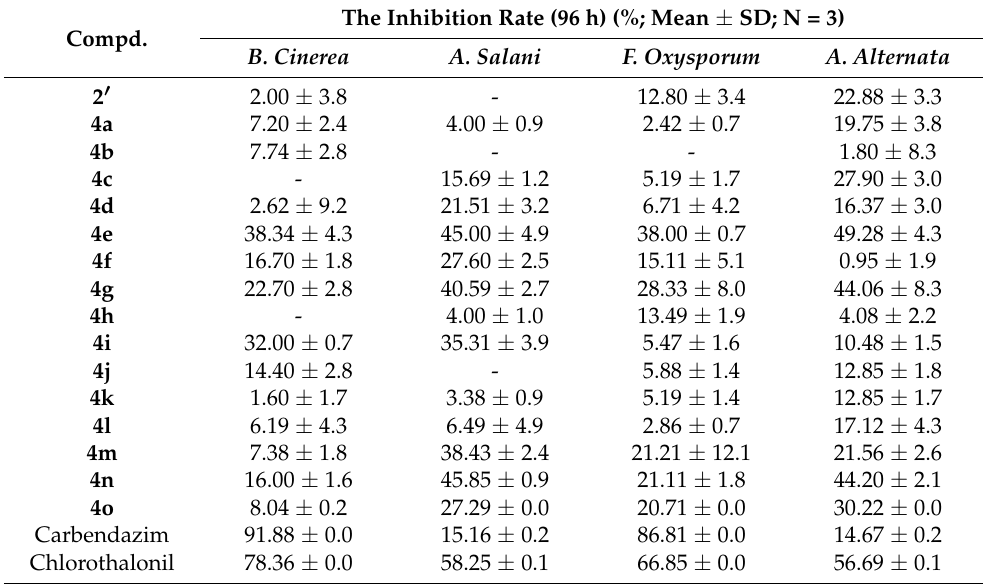
Table 2. Antifungal activity of synthesized compounds with 8-methyl at 200 µ g/mL in 96 h.